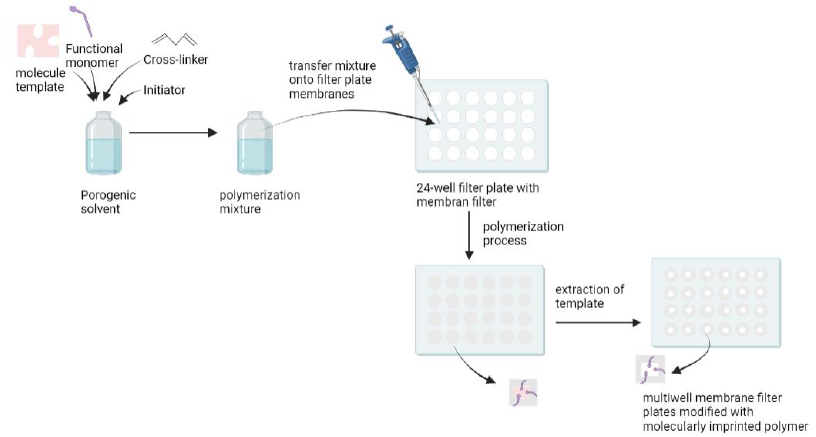
Figure 5. Multiwell membrane filter plates modified with MIPs.